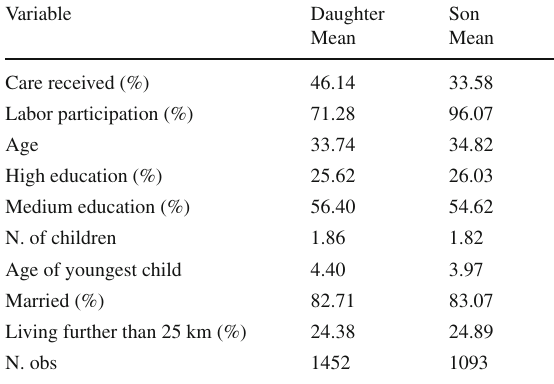
Table 6 Descriptive statistics offspring. Source : SHARE